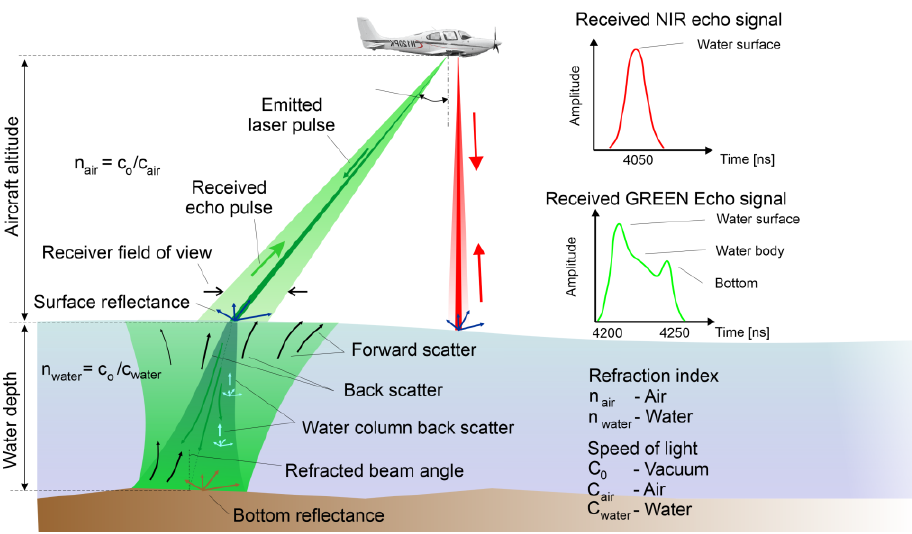
Figure 3. Topographic (NIR) and topo-bathymetric (green) laser scanners mounted on the same airborne platform; ( left ) reflection of NIR signal at water surface; ( right ) principle of airborne laser bathymetry (refraction of laser beam at water surface, echoes from near water surface, water column, and water